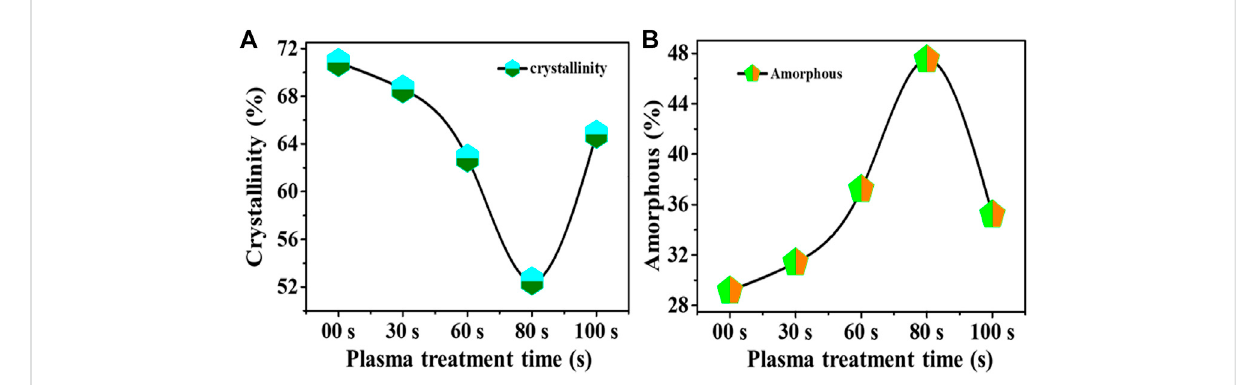
FIGURE 6 Determined: (A) Crystallinity, (B) Amorphous percentage in untreated and plasma treated